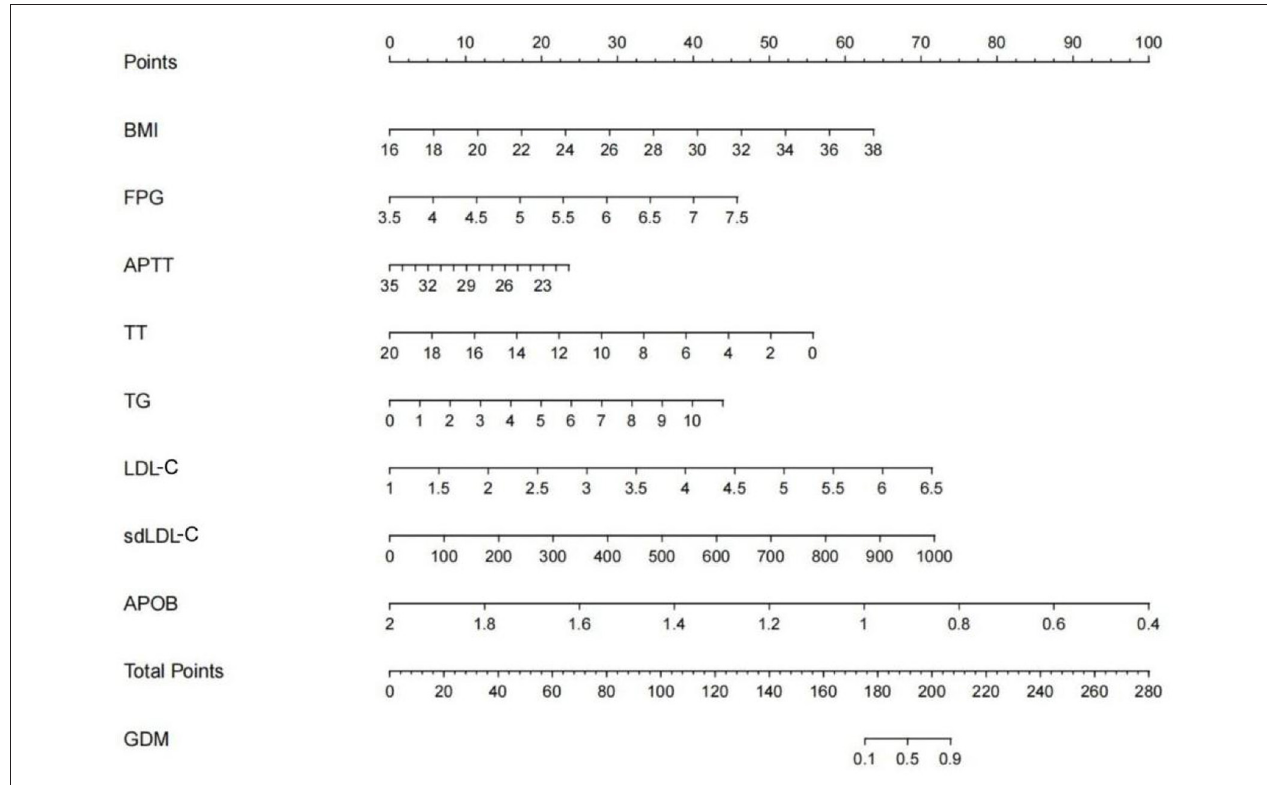
FIGURE 4 | The nomogram of predictive model for GDM. Patient prognostic values were located on the axis of each variable. A vertical line was then drawn from that value to the top points scale to determine the number of points for that particular variable. The sum of these numbers was located on the total score axis, and a line was drawn at a 90 ◦ angle downward to the GDM risk axis to determine the risk of